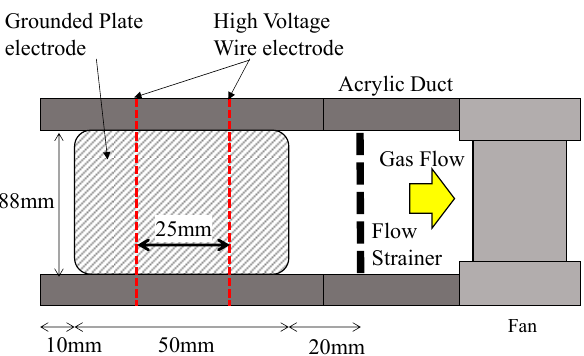
Figure 9. Top view of the electrostatic precipitator. The gas flow is from the left to the right. The treated gas propelled the fan, and the exhaust gas flows into the downstream duct.